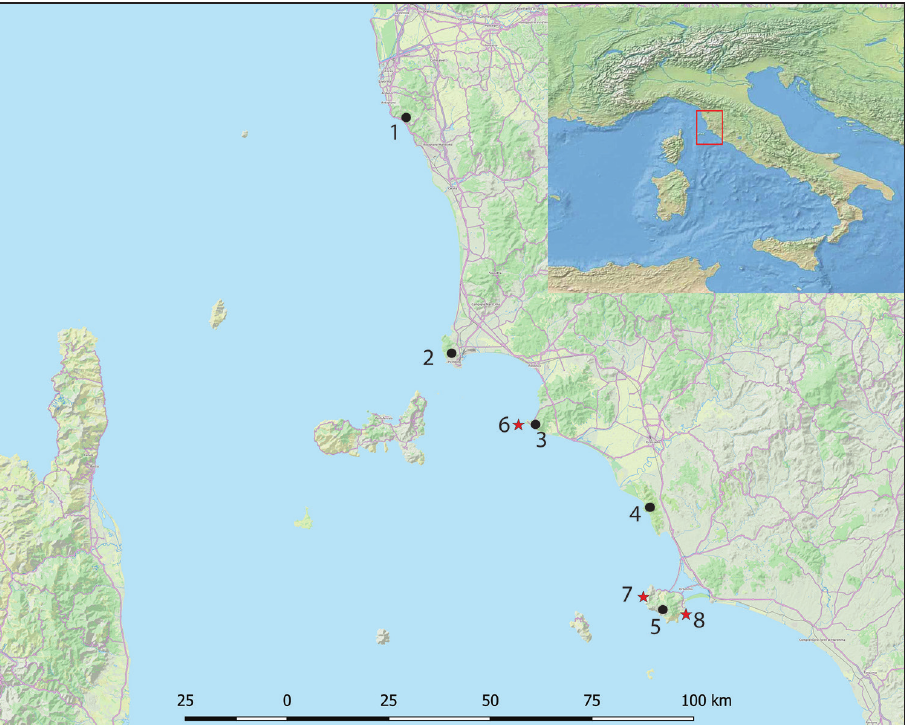
Figure 8. Geographic range and distribution map of Limonium multiforme